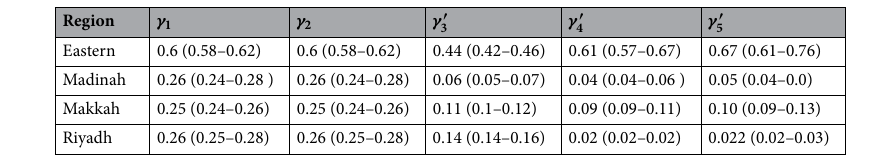
Table 4. Estimated ascertainable infection